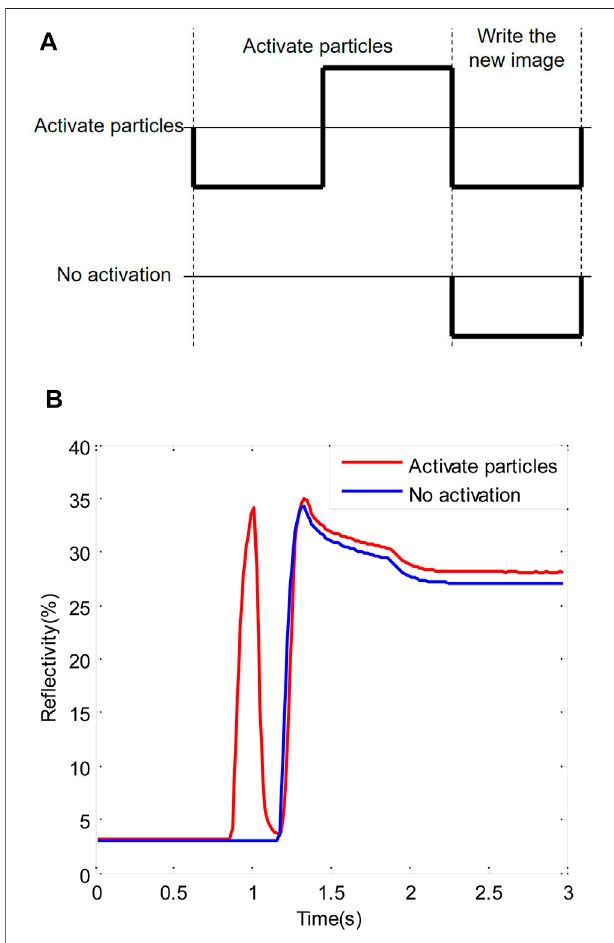
FIGURE2| Re fl ectancecurvesofanEPDwhichisdrivenbytwokindsof driving waveform (A) EPD driving waveforms. (B) Re fl ectance curves of an EPD according to driving waveforms, the driving waveform with an active particles stage can obtain higher re fl